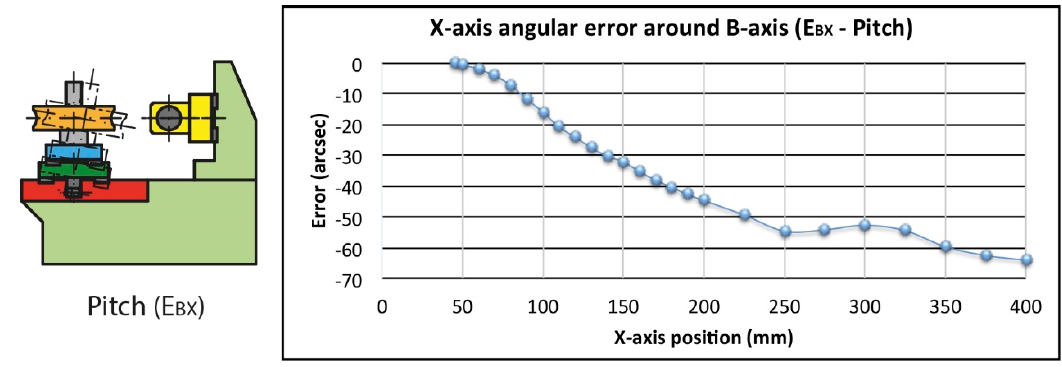
Figure 6. Pitch error (E BX ).